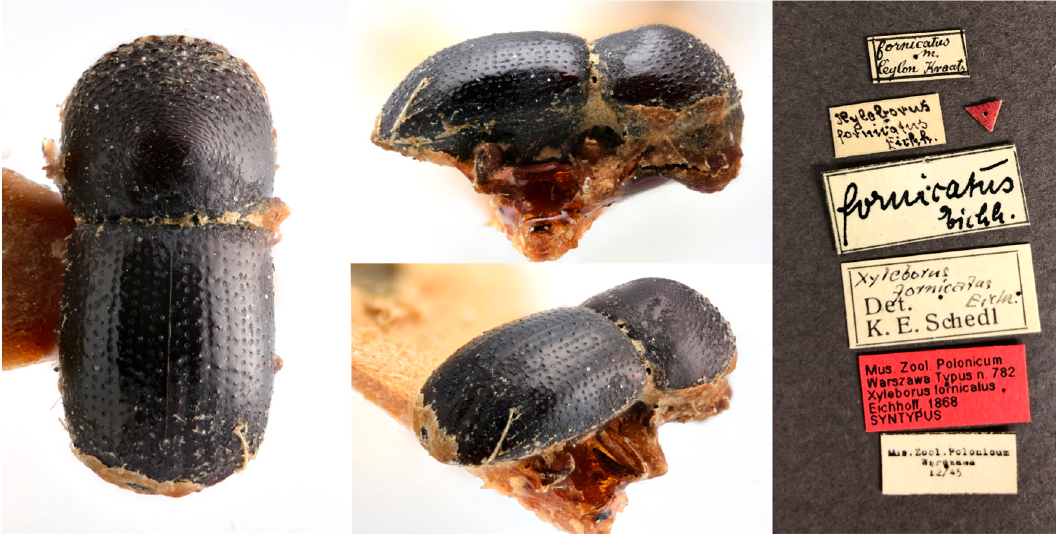
Figure 1. Syntype of Xyleborus fornicatus , female, from left to right: dorsal view, lateral view, posterior oblique view of declivity, and label information. Body length of 2.62 mm.